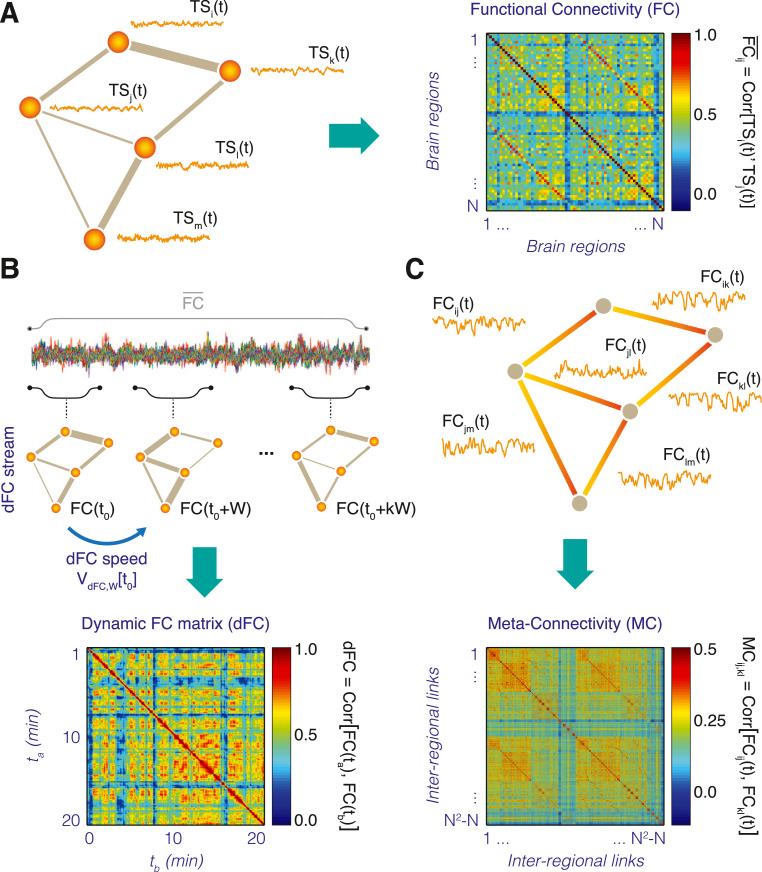
From Functional Connectivity to Functional Connectivity Dynamics. (A) Traditionally, correlations between neural activity time-series TSi(t) of N different brain region nodes i and j (left) are averaged over long times and compiled into the entries FCij of a ‘static’ N-times-N Functional Connectivity (FC) matrix (right). (B) Sliding windows of a shorter temporal duration, it is possible to estimate a stream of time-resolved FC(t) networks, which we call the dFC stream (top). The variation between a FC frame at a time t0 and the next non-overlapping frame at a time t0 + W is measured by the dFC speed VdFC,W(t0) where W is the chosen window size. The degree of similarity (inter-matrix correlation) between FC(t) networks observed at different times is then represented into a F-times-F recurrence matrix, or dynamic Functional Connectivity (dFC) matrix, where FT is the total number of probed windows (i.e. frames in the temporal network given by the dFC stream), depending on window size and overlap (bottom). (C) Alternatively, one can consider each individual FC link as a dynamic variable FCij(t) attached to the graph edge between two regions i and j (top). Generalizing the construction of the FC matrix in panel (A), we can thus extract a N(N-1)-times-N(N-1) matrix of covariance between the time-courses of different FCij(t) links. We re-baptized this inter-link covariance matrix as Meta-Connectivity (MC) matrix.